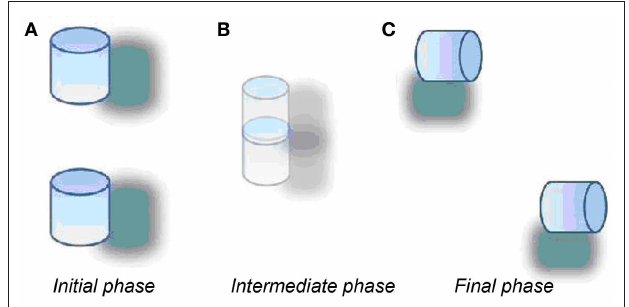
Figure 2 | An exemplar of the abstract category PANiFA; the figure shows three phases – initial (A) , intermediate (B) and final (C) – of the interacting movement. All the other category members were not perceptually similar, but showed similar complex